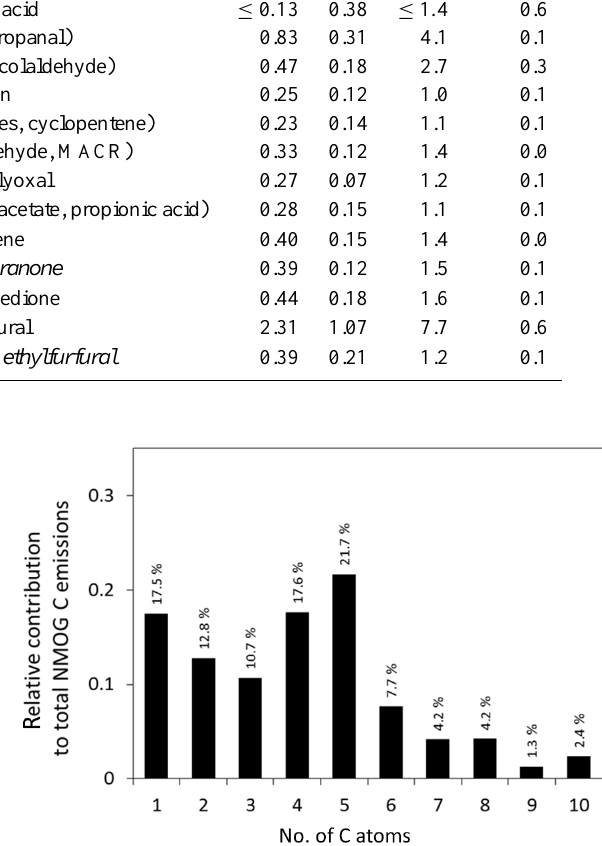
Figure 5. Relative contributions of C 1 –C 10 compounds to total NMOG carbon emissions. C 1 to C 5 compounds each have rela- tive contributions >10% and in sum contribute ∼ 80% of the total NMOG carbon emissions.